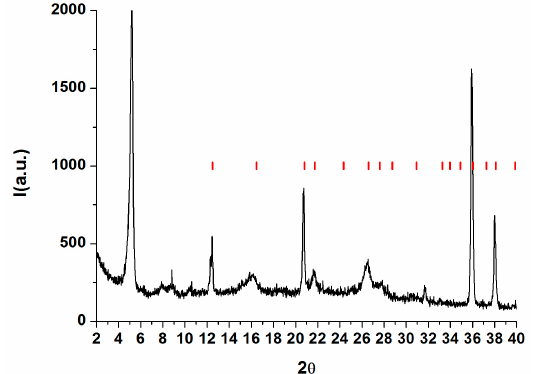
Figure 21. XRD pattern of SSY doped with trans-Hyp (black), crystallographic peaks of trans.Hyp (red). Reprinted with permission from ref. [50]. Copyright 2022, Elsevier.